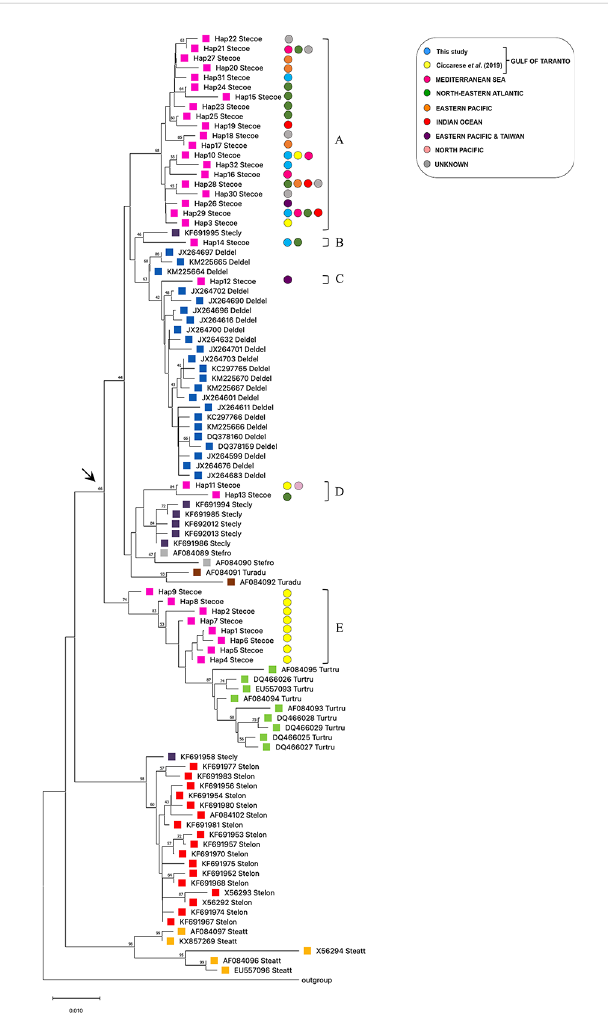
FIGURE 2 NJ tree inferred from Delphinidae cytb sequences. Evolutionary analyses were conducted in MEGA X (Kumar et al., 2018). The optimal tree, with the sum of branch length = 0.52128464 is shown. The tree is drawn to scale, with branch lengths in the same units as those of the evolutionary distances used to infer the phylogenetic tree. The evolutionary distances were computed using the p-distance method (Nei and Kumar, 2000) and are in the units of the number of base differences per site. This analysis involved 98 nucleotide sequences. Codon positions included were 1st+2nd+3rd+Noncoding. All ambiguous positions were removed for each sequence pair. There was a total of 421 positions in the fi nal dataset. The colored circles indicate the geographic origin of the samples of the haplotypes of S. coeruleoalba . Every species is highlighted with a different colored square to enhance the distribution on the phylogenetic tree. The arrow indicates the paraphyletic branches containing the Stenella coeruleoalba haplotypes. Letters from (A – E) indicate striped dolphin